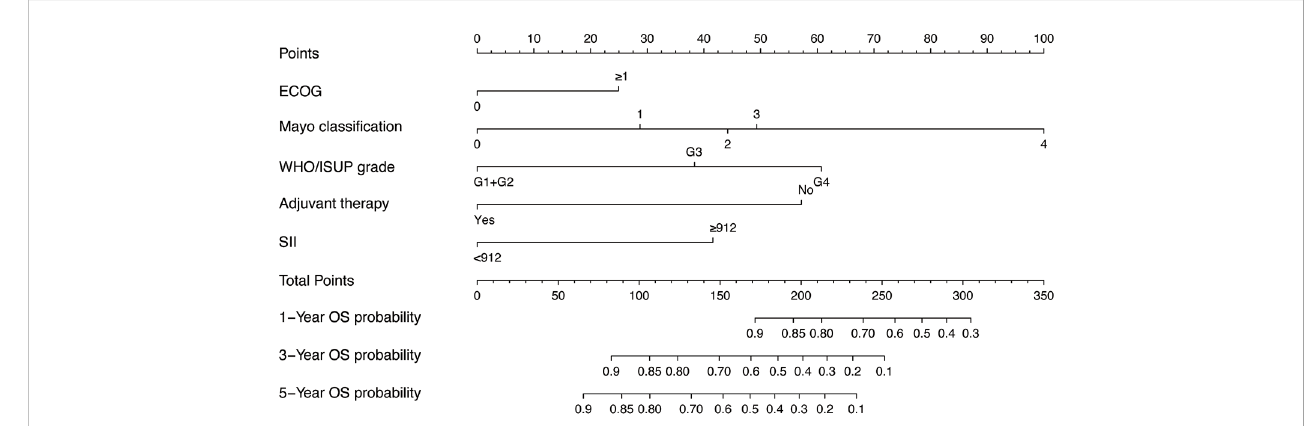
FIGURE 3 The nomogram for predicting 1-, 3-, and 5-year OS probabilities.